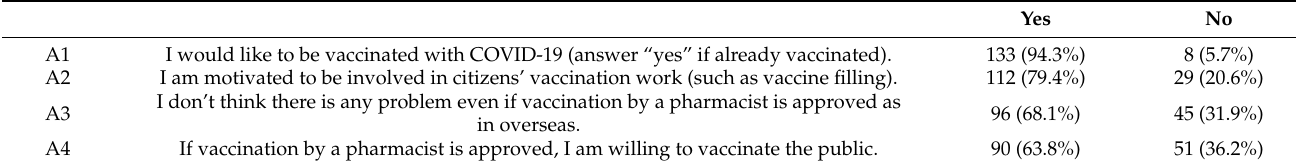
Table 3. Respondents’ answers on COVID-19